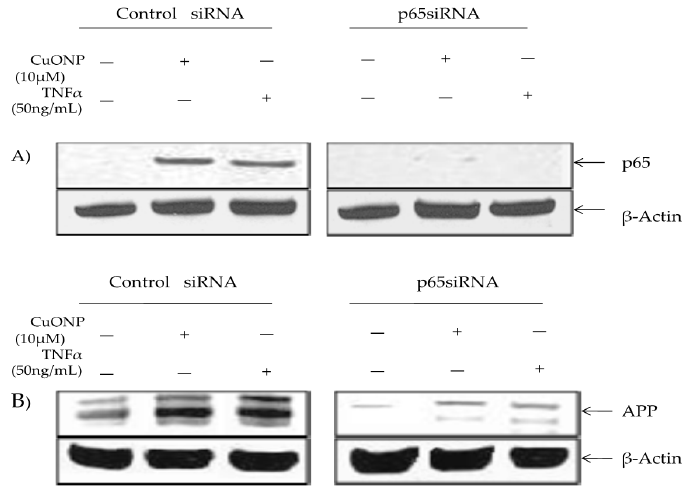
Figure 5. Effect of p65 knockdown on amyloid precursor protein (APP) induction by CuONPs and TNF α . Effects of p65 siRNA (15 nM) on APP induction by CuONPs and TNF α were assessed. SH-SY5Y cells were plated at 2 × 10 6 /well and transfected with either control siRNA or p65 siRNA. After 24 h, transfected cells were exposed to either CuONPs (10 µ g / mL) or TNF- α (50 ng / mL) for 6 h. Cells were lysed and lysates blotted for p65 ( A ) or APP ( B ), and β -actin as a